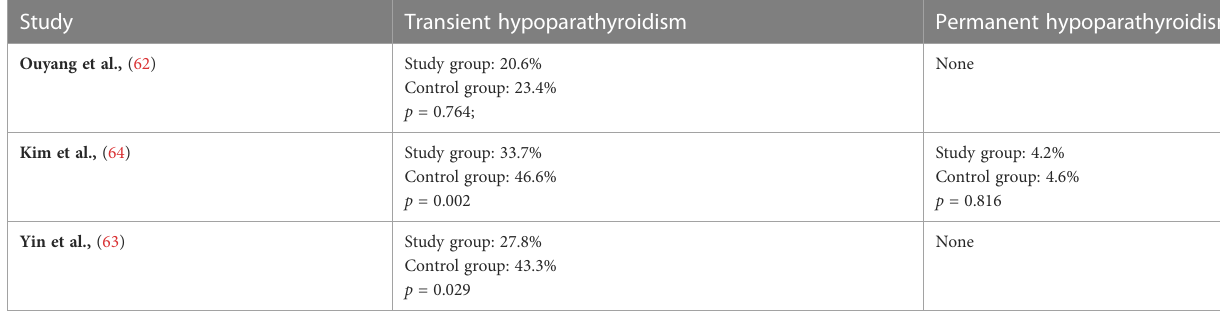
TABLE 3 Rates of transient and permanent hypoparathyroidism in the reviewed